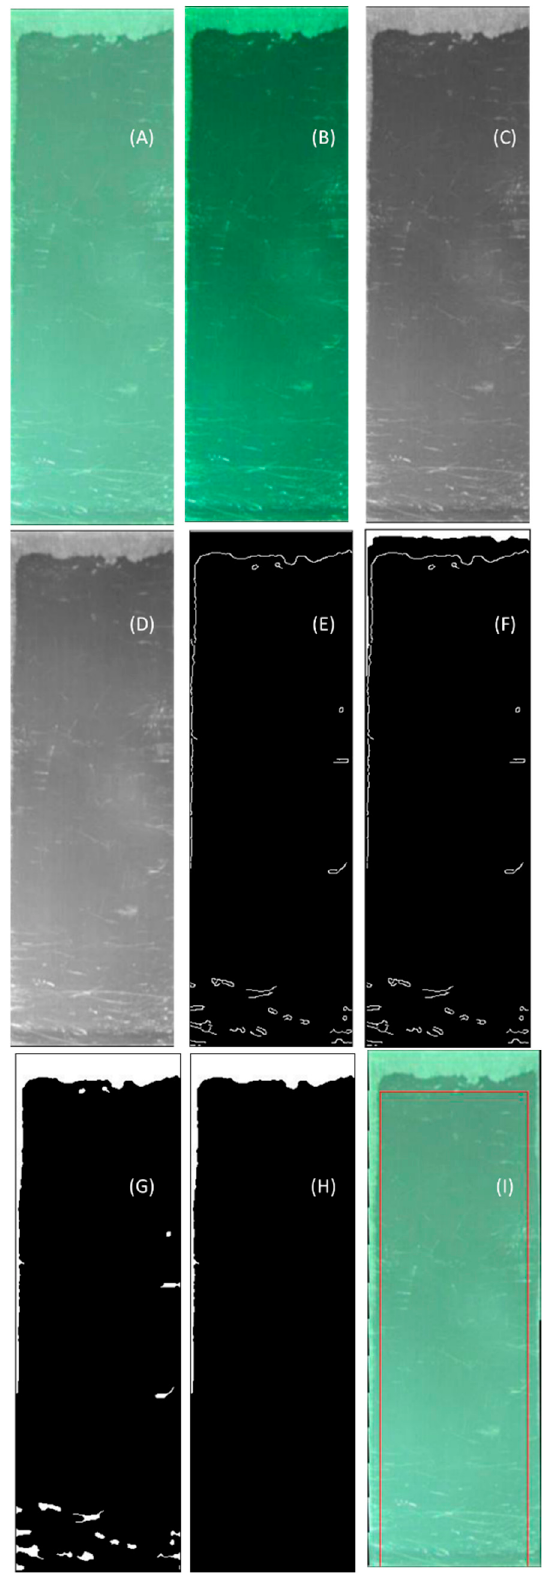
Figure 3. WSET detection algorithm for WSET ( A ) original image, ( B ) gamma adjustment, ( C ) grayscale RGB conversion, ( D ) Kalman filter, ( E ) contours detection with algorithm of canny, ( F ) addition with what has been previously detected, ( G ) fill holes, ( H ) largest connected region, and ( I ) representation of the failure zone.